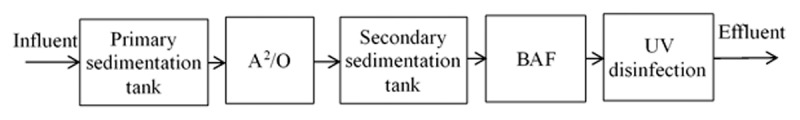
Treatment process for the chosen municipal wastewater treatment plant.